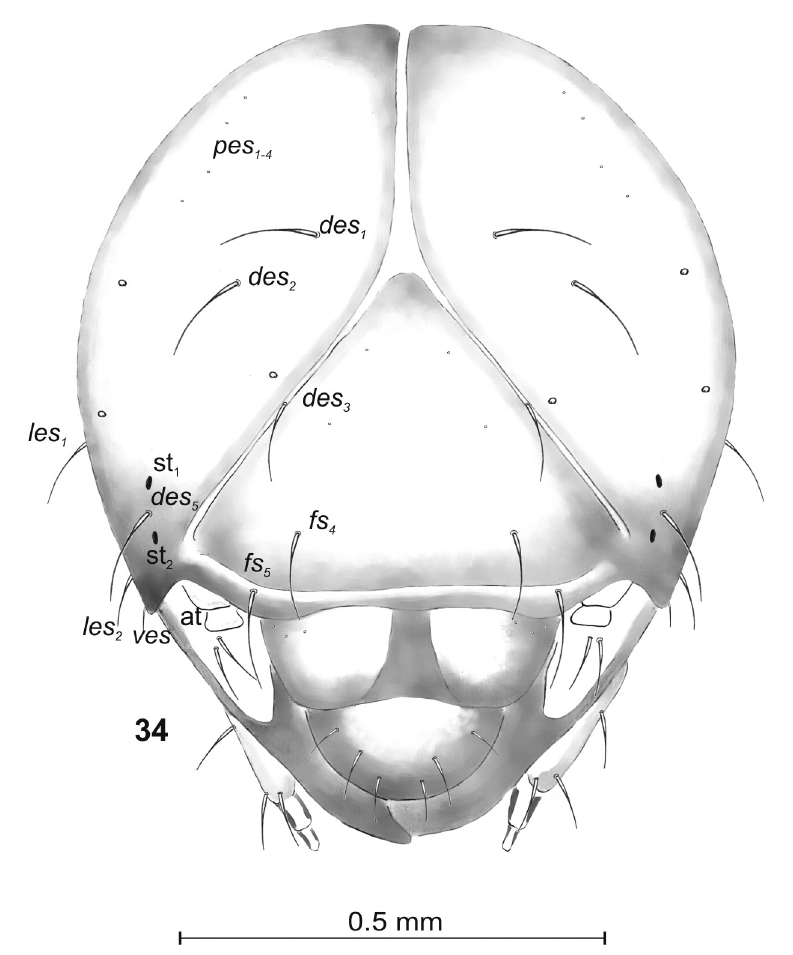
Figure 34. Strophosoma sus , larva of high instar, head. Abbreviations: at – antenna st – stemmata. Setae: des - dorsal epicranial, fs – frontal, les - lateral epicranial, pes – postepicranial, ves –